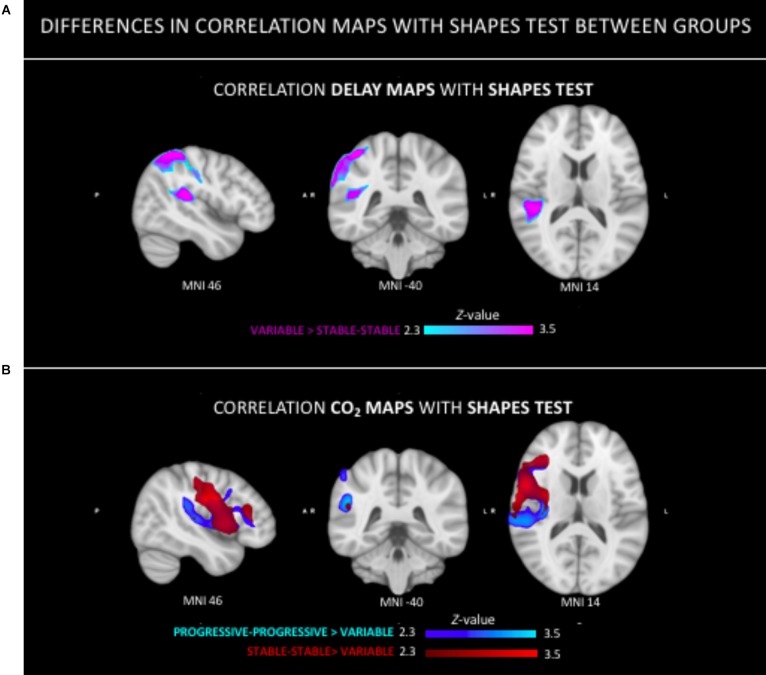
Group differences in the relation between neuroimaging parameters (ASL, CVR-CO2) and Shapes test performance. (A) Stronger positive relationship in the tempo-parietal junction and superior parietal lobe in V group as compared to the SS group. (B) Stronger positive correlation in both the PP and SS group as compared to the V group in right peri-sylvian and superior areas.